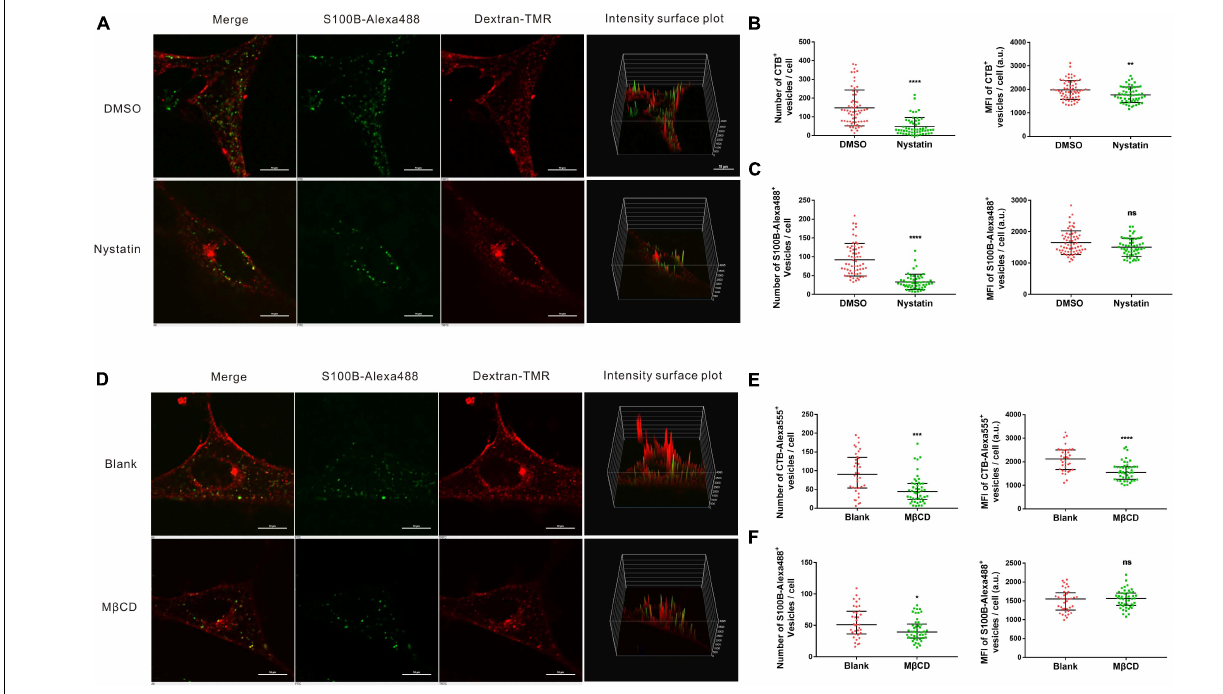
FIGURE 7 | Internalization of S100B-Alexa488 by MSCs is partially dependent on lipid rafts. (A–C) Effects of nystatin on the uptake of S100B-Alexa488 and CTB-Alexa555. MSCs were pretreated with nystatin or DMSO and then incubated with S100B-Alexa488 (0.1 µ M) and CTB-Alexa555 (0.5 µ g/ml) for 2 h. (A) Representative live cell confocal images. Scale bar, 10 µ m. (B,C) Quantified data showing the number and MFI of (B) CTB-Alexa555- and (C) S100B-Alexa488-positive vesicles. (D–F) Effects of M β CD on the uptake of S100B-Alexa488 and CTB-Alexa555. MSCs were pretreated in the absence or presence of M β CD and then incubated with the two fluorescent probes for 2 h as described in section “Materials and Methods”. (D) Representative live cell confocal images. Scale bar, 10 µ m. (E,F) Quantified data showing the number and MFI of (E) CTB-Alexa555- and (F) S100B-Alexa488-positive vesicles. Data are presented as the median and interquartile range (IQR), n (DMSO) = 64 cells; n (Nystatin) = 55 cells; n (Blank) = 36 cells; n (M β CD) = 46 cells. * P < 0.05, ** P < 0.01, *** P < 0.001, **** P < 0.0001, ns, not significant versus the control group.